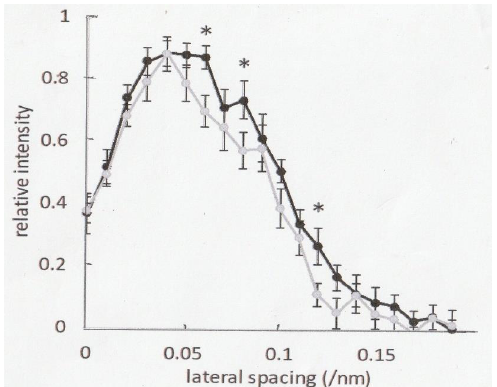
Figure 3. Changes in the average intensity profile of the 5.9 nm actin-based layer lines from high-Ca rigor fibers, obtained from 8 preparations before (black line) and after (grey line) ramp-shaped releases. The intensity profiles were constructed from averaged data points, measured at 20 different positions of lateral spacing. Each asterisk (*) indicates significant difference ( p < 0.05) between the values before and after release. For further explanation, see text.